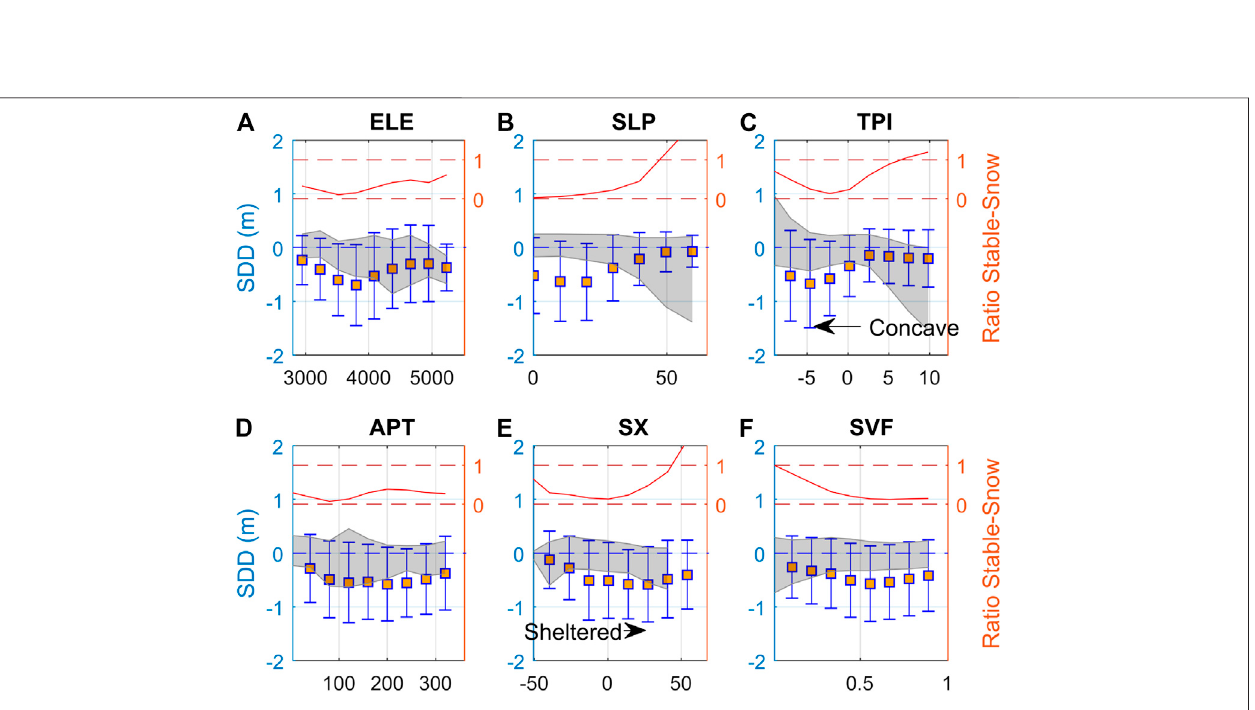
Frontiers in Earth Science |